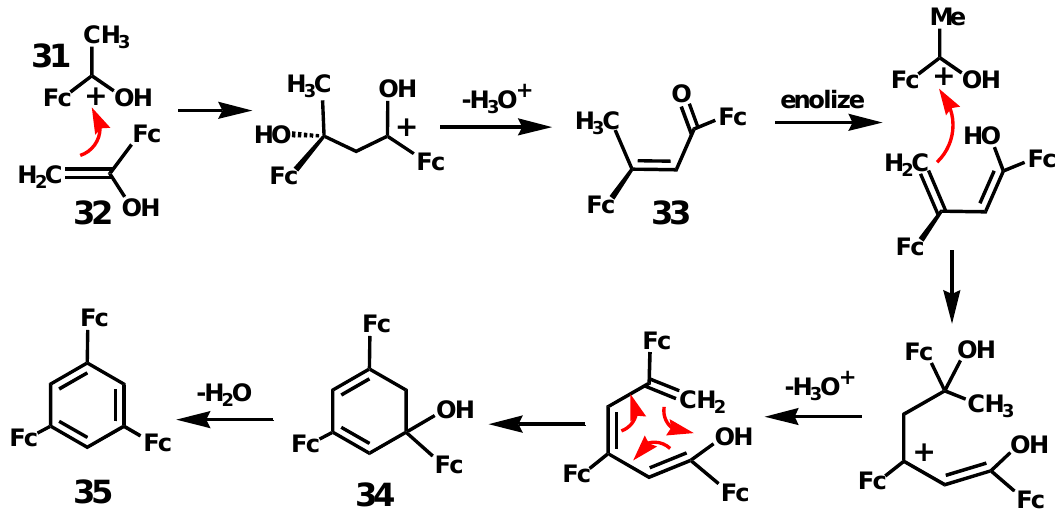
Scheme 8. Proposed mechanism for the cyclization of (CH 3 C(=O)C 5 H 4 )ML n precursors, where ML n = Fe(C 5 H 5 ) or Mn(CO) 3 , to form 1,3,5-trisubstituted benzenes.